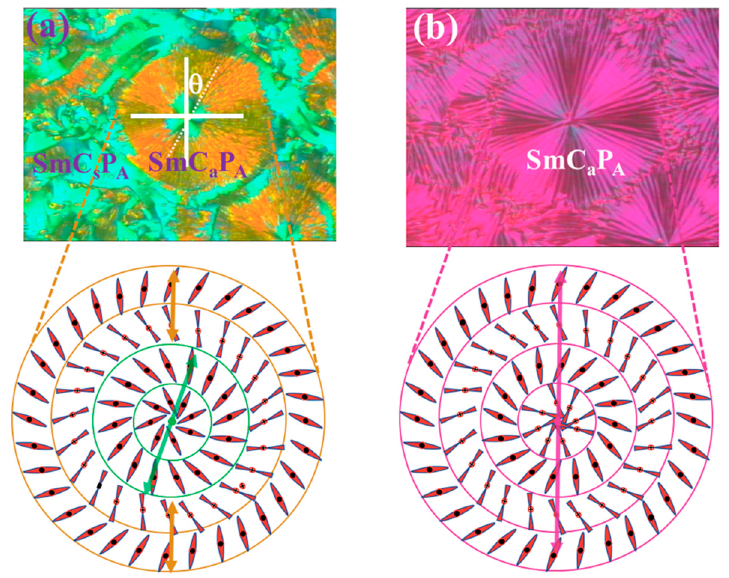
Figure 7. Representative POM textures of d = 4 µm B-10(S) film and their schematic director and layer structures of the circular area in the center of the image in the SmCP A phase at 118 °C. ( a ) Texture and schematics of the director and layer structure of the central circularly shaped domain after cooling at zero field from the isotropic phase; ( b ) texture and schematics of the director and layer structure of the central circularly shaped domain after driving with 12 V/µm, f = 12 Hz square wave field .